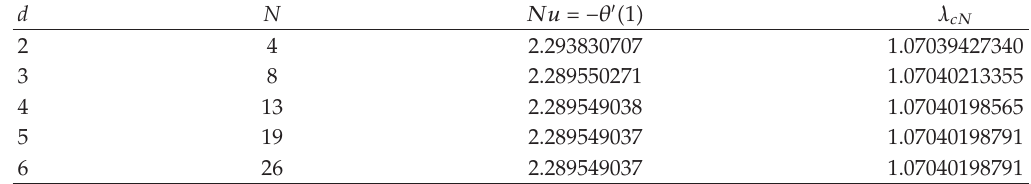
Table 1: Computations showing the criticality procedure rapid convergence (cid:5) β (cid:8) n (cid:8) 1 , θ w (cid:8) ε (cid:8) 0 (cid:6) .